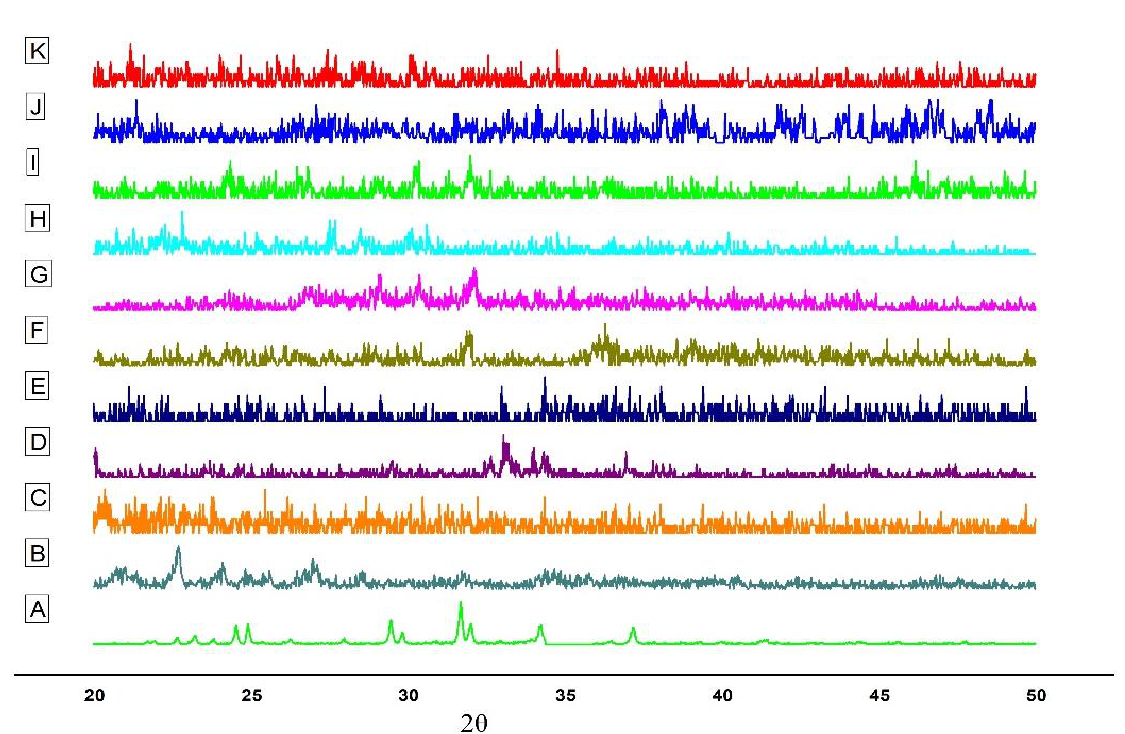
Figure 2. PXRD of ( A ) EPL, ( B ) CS, ( C ) sTPP, ( D ) β -CD ( E ) SBE 7 β -CD ( F ) NP1 ( G ) NP2, ( H ) NP3, ( I ) NP4, ( J ) NP5 and Figure 2. P XRD of ( A ) EPL, ( B ) CS, ( C ) sTPP, ( D ) β-CD ( E ) SBE 7 β-CD ( F ) NP1 ( G ) NP2, ( H ) NP3, ( K ) ( I ) NP4, ( J ) NP5 and ( K ) NP6.